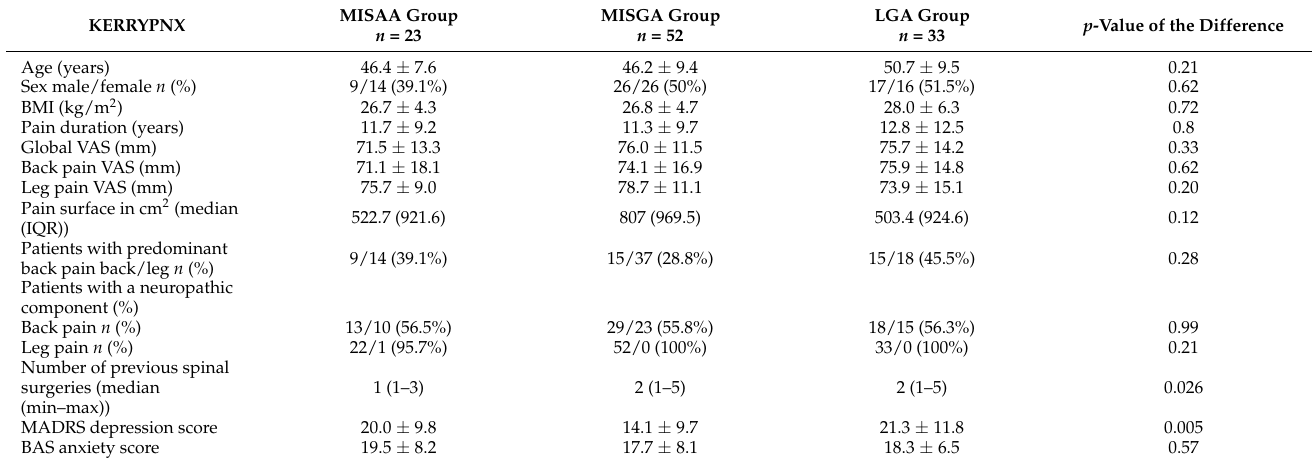
Table 1. Baseline characteristic comparisons between the MISAA, MISGA and LGA groups.